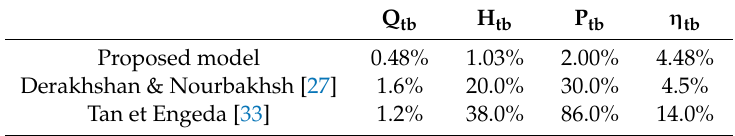
Table 2. Comparison of the average BEP prediction errors for di ff erent models from the literature. Q tb H tb P tb η tb Proposed model 0.48% 1.03% 2.00% 4.48% Derakhshan & Nourbakhsh [27] 1.6% 20.0% 30.0% 4.5% Tan et Engeda [33] 1.2% 38.0% 86.0%